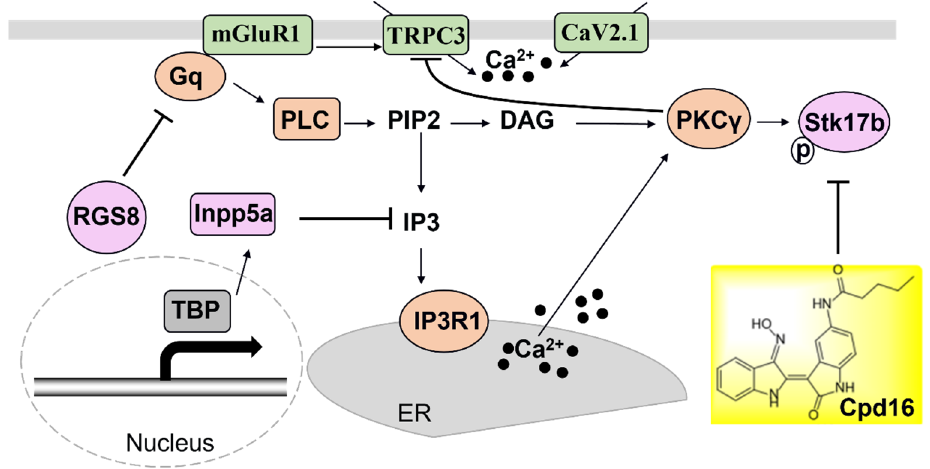
Figure 1. The recently reported molecules RGS8, Inpp5a and Stk17b are involved in the mGluR1- PKC γ signaling pathway in the cerebellum. A new drug, Cpd16 has been shown to work as inhibitor to Stk17b, which can regulate the downstream mGluR1 signaling pathway.